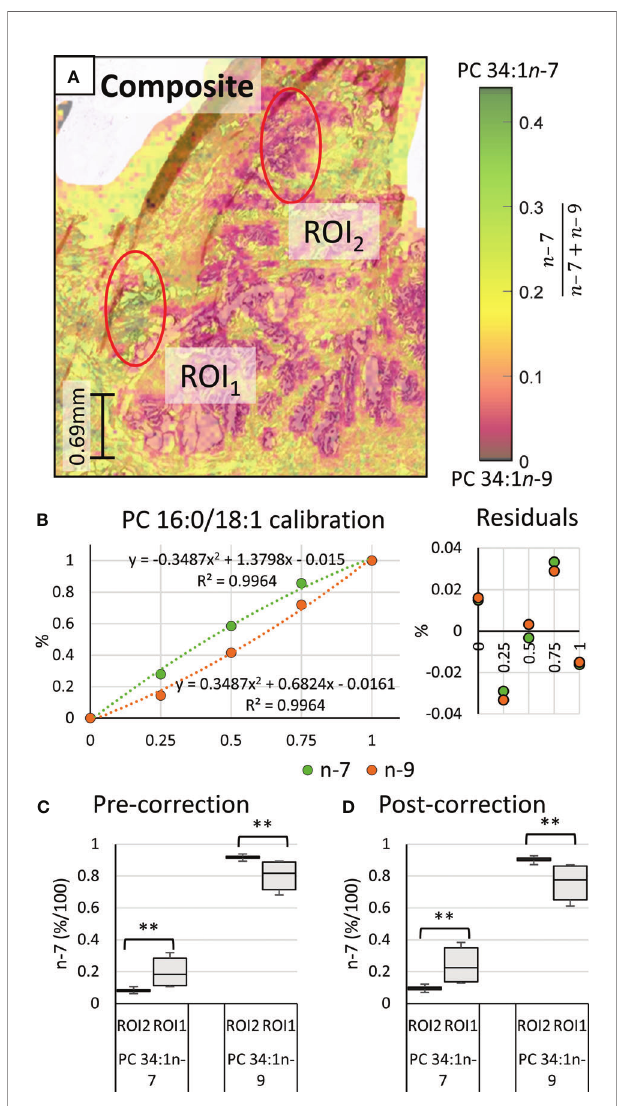
FIGURE 3 | Haematoxylin and eosin stained tissue and calibration of mass spectral data to mol%. Comparison of two regions of interest (ROI) independently determined by two pathologists as in fl ammation (ROI 1 ) or abnormal prostate epithelia (ROI 2 ). (A) Overlay of the H&E stain and the PC 34:1 n -9 and PC 34:1 n -9 FDIs. Colour scale shows the fraction of n-7 (relative to total n -9 + n -7) from 0.0 (orange/black) to 0.45 (green/black). (B) Calibration curves and measurement residuals obtained from OzID analysis of reference standards PC 16:0/18:1 n- 7 and PC 16:0/18:1 n- 9. (C) The fractional ion abundance of isomer-speci fi c OzID product ions corresponding to PC 34:1 n- 7 and PC 34:1 n- 9 displaying distribution of data across patient tissue ROIs (mean and standard deviation of 44 sampling regions). (D) The relative molar abundance of PC 34:1 n- 7 and PC 34:1 n -9 in the ROIs, based on the calibration and correction with reference standards. Two-tailed paired Welsh ’ s t -test conducted, **p ≤ only a minor increase of S e (0.022 to 0.033) is observed when correcting reference standards with the opposite calibration curve and (ii) the minimal presence of the sn -1 unsaturated isomers in mammalian cells (16), calibration of biological